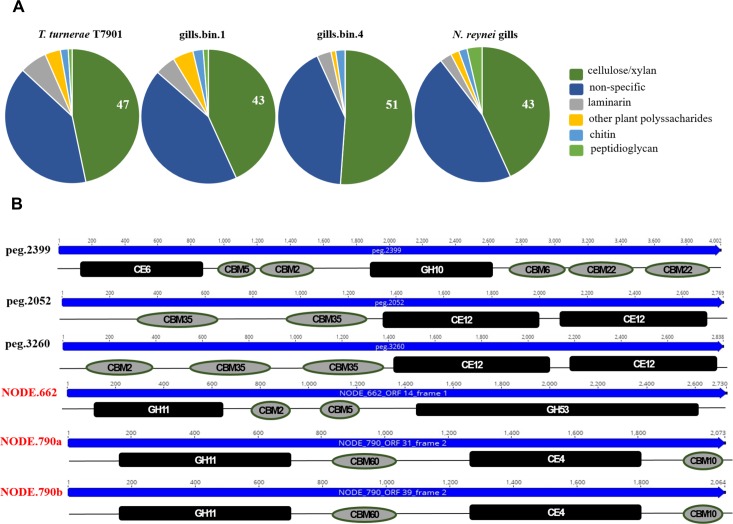
Gill genome bins and un-binned contigs for carbohydrate active enzymes (CAZymes).A) Proportion of GH domains according to the substrate specificity at gills.bin1 and gills.bin 4 binned genomes and at other un-binned contigs from gills metagenome dataset. Substrate specificities as previously defined [9]: dark green = cellulose/xylan GH families (5, 6, 8, 9, 10, 11, 12, 44, 45, 51, 52, 62, and 74); dark blue = GH families with other or not-unique specificities (1, 2, 3, 13, 15, 23, 27, 30, 31, 35, 39, 43, 73, 77, 78, 79, 94, 95, 103, 108, 109, 115, 128, 130); light grey = laminarin GH families (16 and 81); yellow = other plant cell wall polysaccharides GH families (26, 53, and 67); light blue = chitin GH families (18, 19, and 20); light green = peptidoglycan GH families (28 and 105). B) Novel multicatalytic CAZymes configurations detected on Teredinibacter sp. gills.bin.4 genome bin (labeled in black), and on un-binned contigs from gill-symbiotic gammaproteobacterial community (labeled in red). Abbreviations key: glycoside hydrolases (GH), carbohydrate esterases (CE), carbohydrate binding modules (CBM). Catalytic domains and binding modules are color coded as black squares and gray circles.